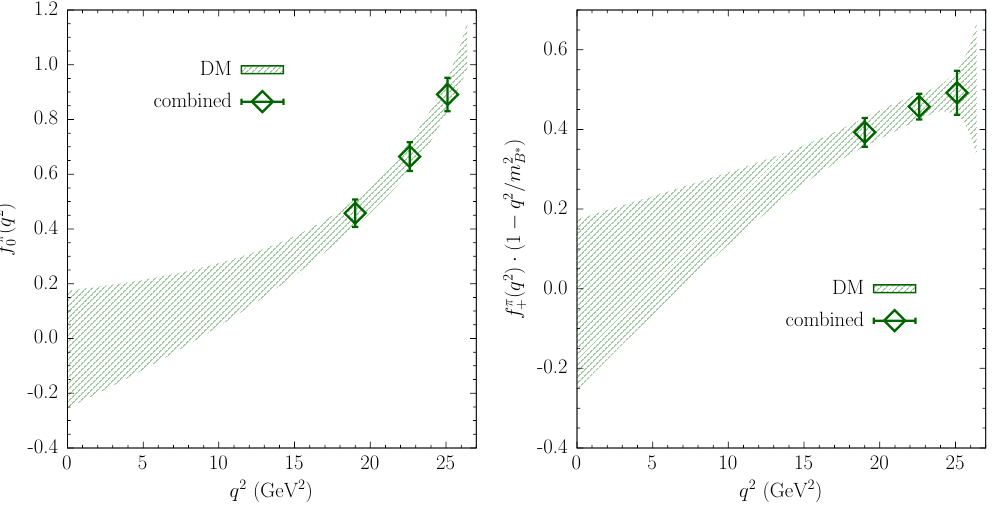
( q 2 ) (left panel) and vector f π ( q 2 ) (right panel) FFs entering Figure 2 . The bands of the scalar f π + 0 the semileptonic B → π‘ν decays computed by the DM method at 1 σ level using as lattice inputs ‘ the combined LQCD data of table 1, shown as green diamonds. In the right panel the vector FF is multiplied by the factor (1 − q 2 /m 2 ) with m = 5 . 325 GeV. B ∗ B ∗